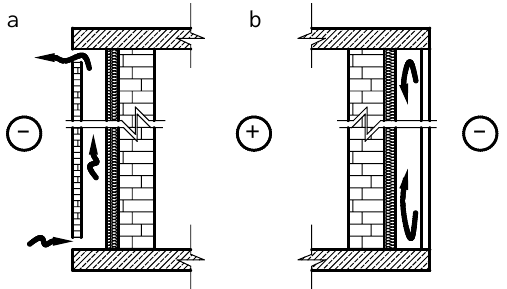
Fig. 1. Schemes for walls having small air gaps used for numerical modelling: a (cid:1) ventilated small air gap (open); b (cid:1)